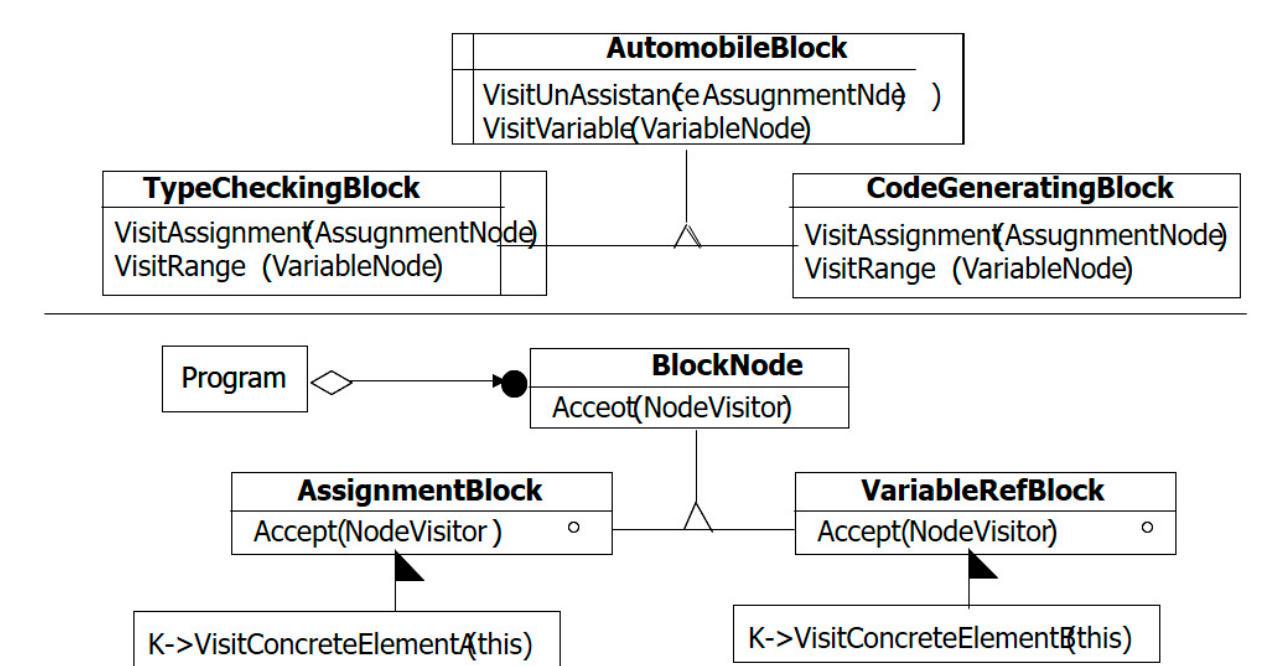
Figure 9. Automobile Malicious Code Verification Composite Diagram.